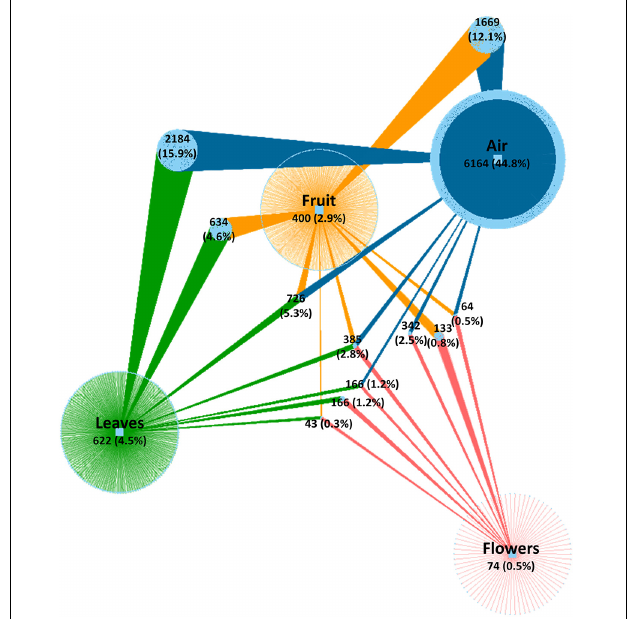
FIGURE 1 | Network of shared and unique fungal OTUs among investigated samples. Colored edges (links) represent OTUs associated to sample types (air, fruit, leaves, and flowers). Light blue circle nodes connecting two or more samples represent shared OTUs. Numerical values indicate the number of OTUs and their percentage relative to the total number of OTUs.